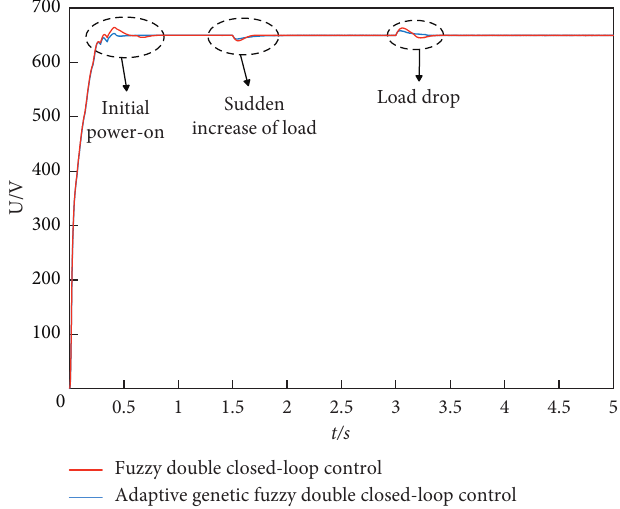
Figure 11: Microgrid 2 bus voltage